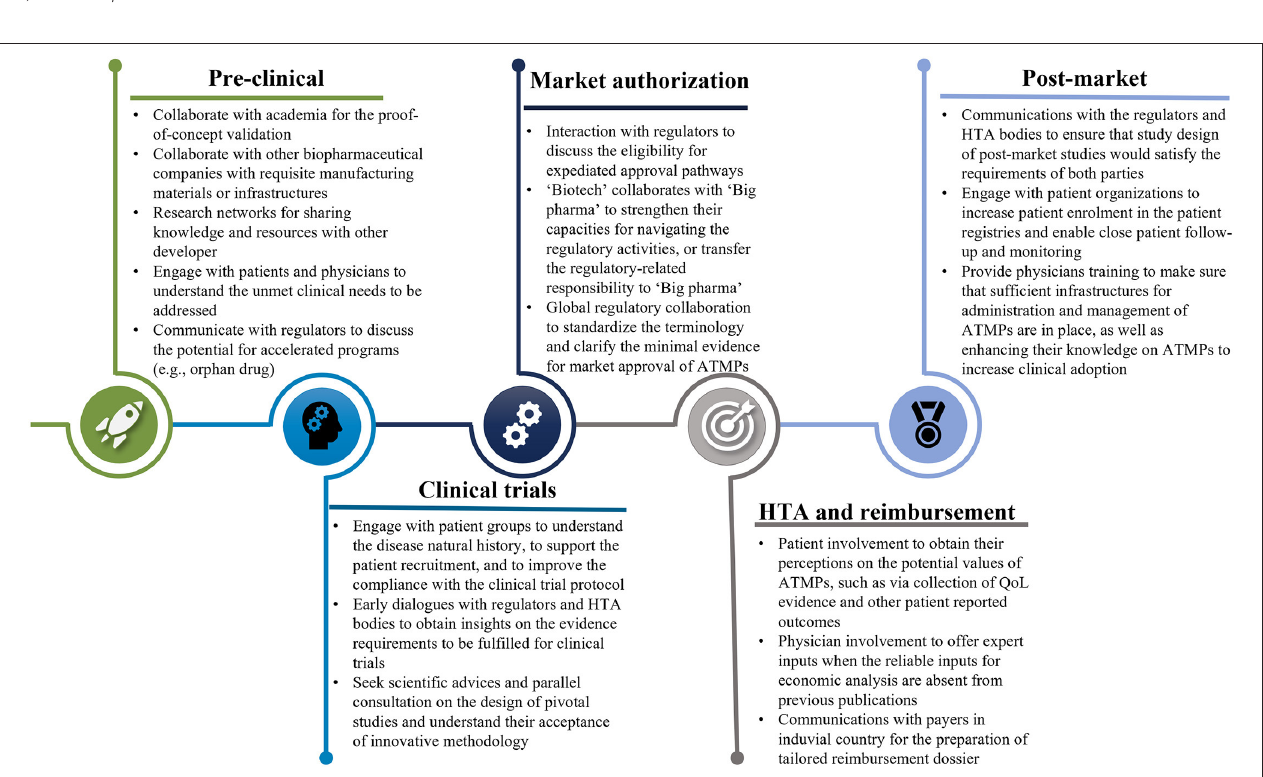
FIGURE 1 | The collaborations with all stakeholders throughout the development of ATMPs. ATMPs, advanced therapy medicinal